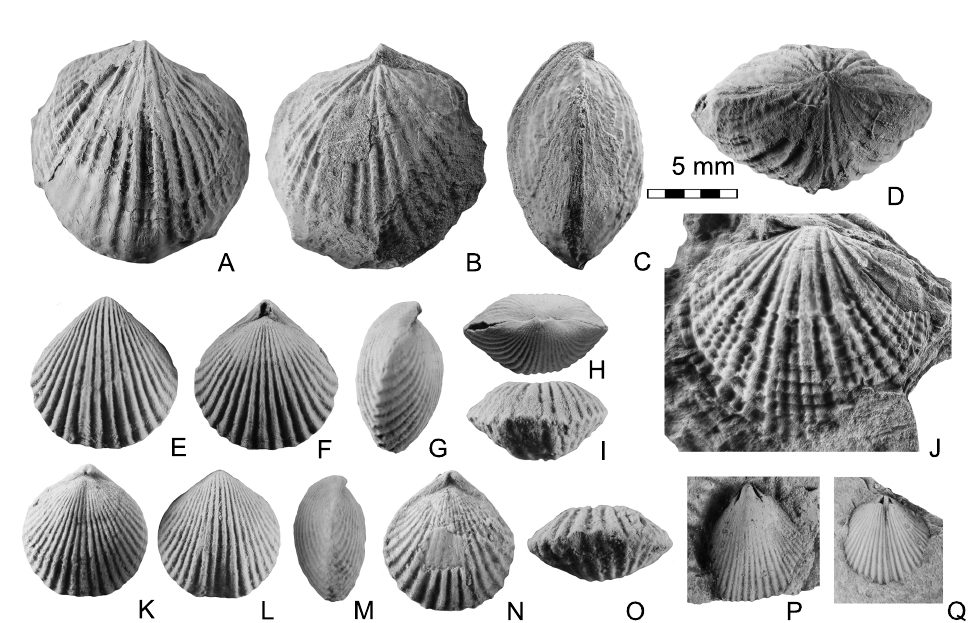
Figure 1. Eiratrypa thorslundi gen. nov. (A–D) PMO 158.043h Pedicle, brachial, side and posterior view from section along highway E18 at Hofstad, (J) PMO 158.107u brachial view, 52–57 m above the base of the profile, Skytterveien. Both refigured from Baarli (2021a), figure 12, Leangen Member, Solvik Formation, Asker. Clintonella aprinis (E–I) GIT 849-15, pedicle, brachial, side, posterior and anterior view (sectioned). (K, L, M) GIT 849-14, brachial, pedicle, side view. (N, O) GIT 849-18, brachial and anterior view, all from the local Juuru stage at Kuimetsa paemurd, Raplamaa, Estonia. (P) PMO 105.238, mould of pedicle valve. (Q) PMO 157.989, mould of brachial valve. Both refigured from Baarli (2022), figure 24, from a level 32 m above the base of Leangen Member, Leangen,